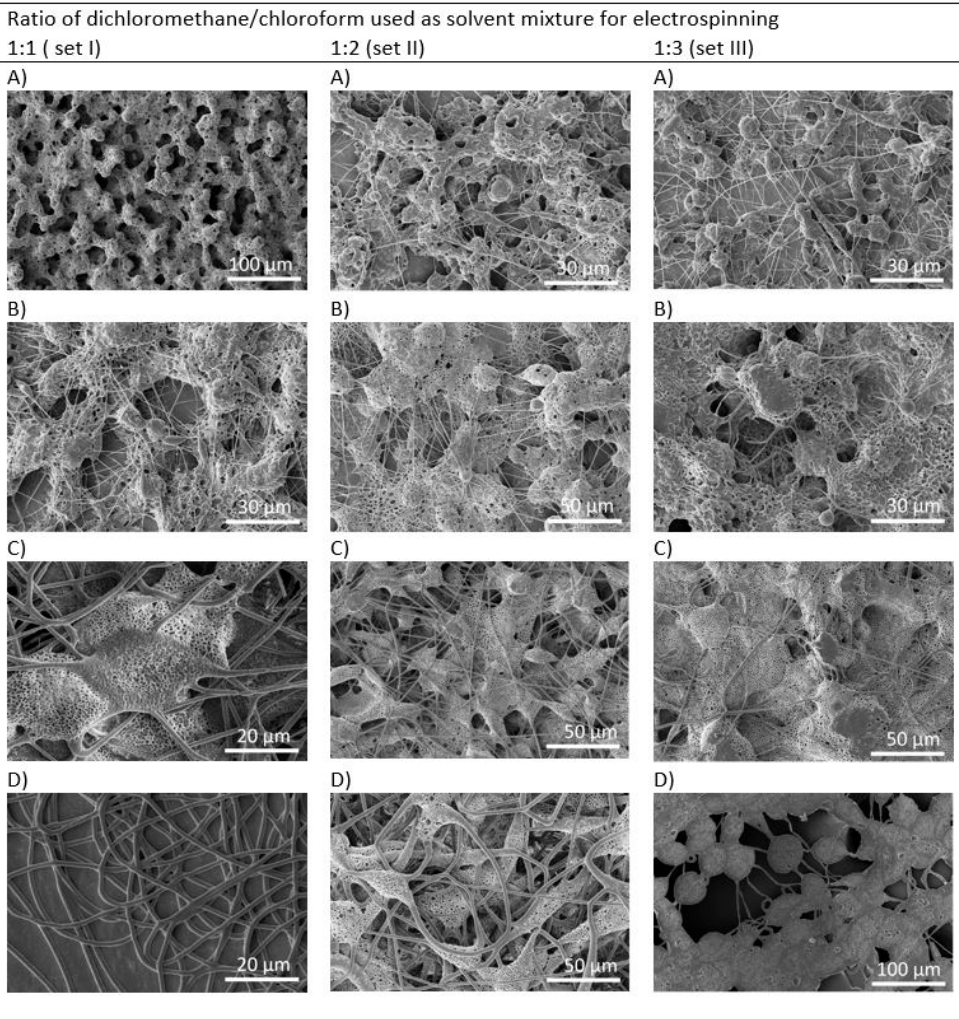
Figure 1. SEM morphology of electrospun meshes processed from dichloromethane/chloroform solution and PHB in the concentration of: ( A ) 1 wt.% (EM_1), ( B ) 2 wt.% (EM_2), ( C ) 4 wt.% (EM_4), and ( D ) 5 wt.% (EM_5).